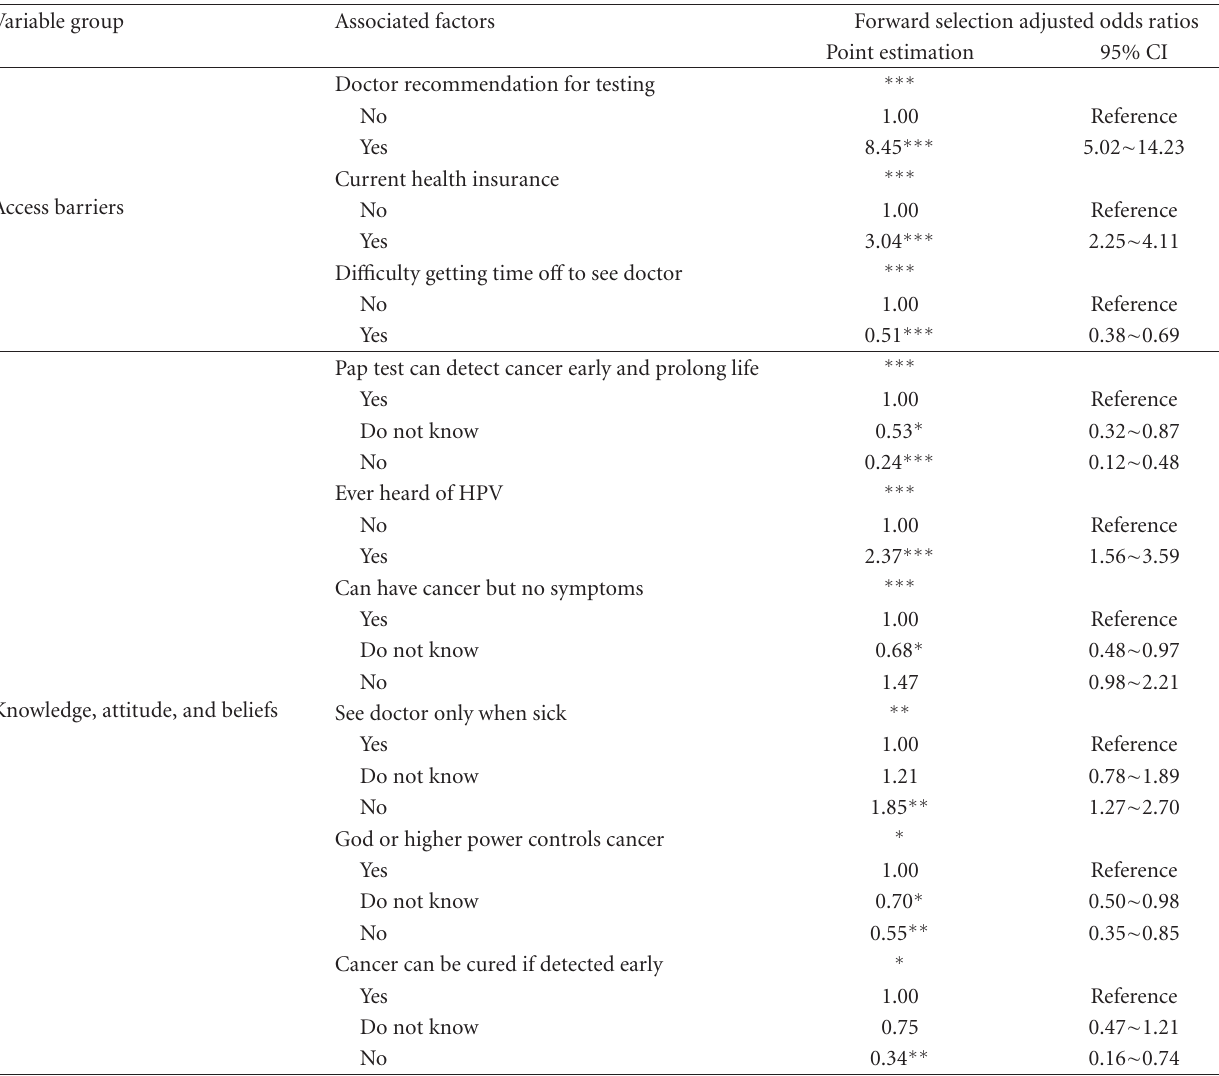
Table 5: Factors associated with receipt of prior Pap test in multivariate